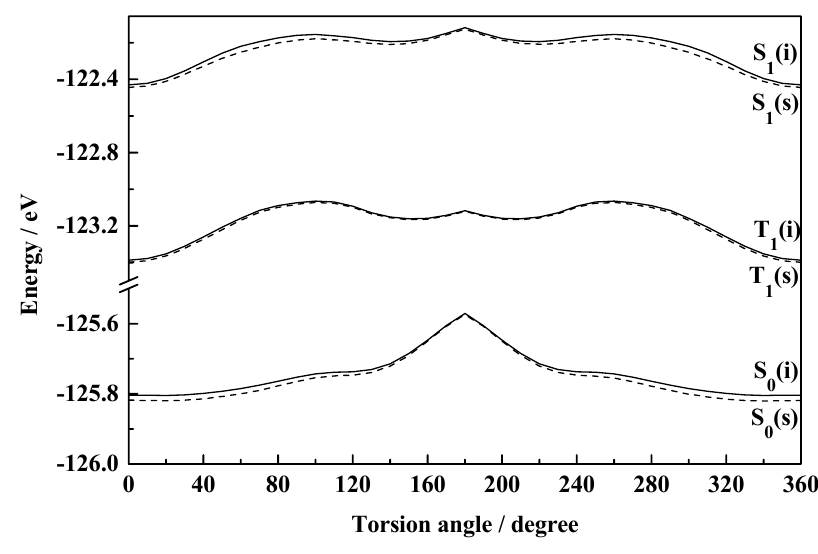
Figure 3. Plot of total molecular energy as a function of torsional angle (7-8-10-11) in S states of HBT (i, isolated; s, solvated in ethanol).